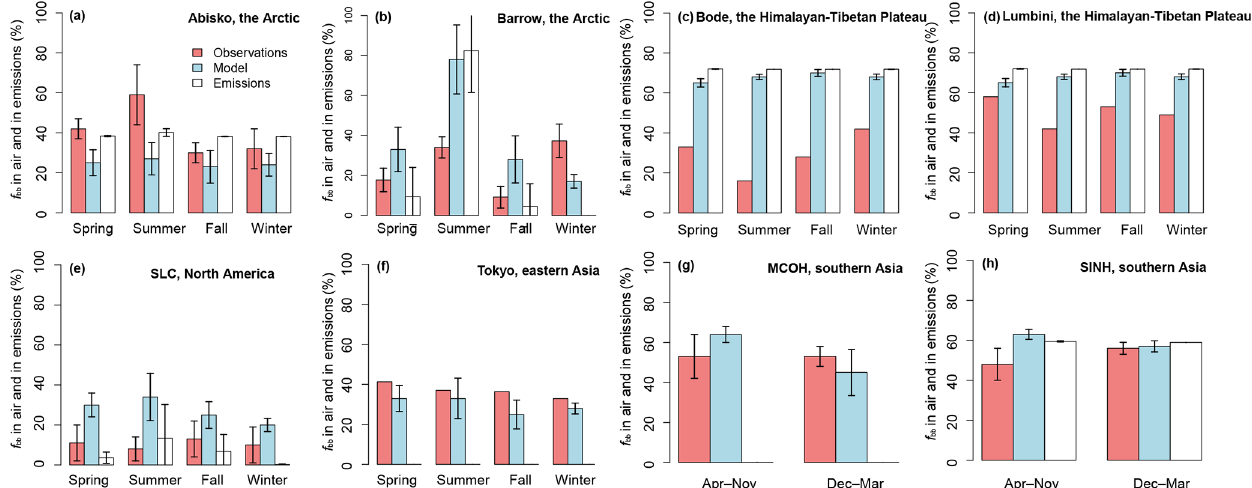
Figure 2. Seasonal variations of observed (light coral bars) and GEOS-Chem-simulated (light blue bars) f bb of BC in the atmosphere at (a) Abisko and (b) Barrow in the Arctic, (c) Bode and (d) Lumbini over the Himalayan–Tibetan Plateau, (e) Salt Lake City in North America, (f) Tokyo in eastern Asia, and (g) MCOH and (h) SINH in southern Asia. The white bars are f bb values of BC emissions in the model grid (4 ◦ lat × 5 ◦ lon) of each site. Also shown are the standard deviations (error bars). Site locations are shown in Fig.